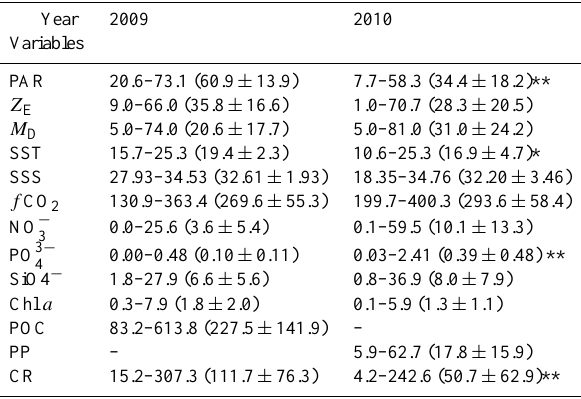
Table 1. Range of different variables with mean ± standard devi- ation (in parentheses) in surface water (2–3m) and averaged val- ues over euphotic depth ( Z E ; m) in the ECS in the spring of 2009 and 2010. Surface water variables include water tempera- ture (SST; ◦ C), salinity (SSS), and fugacity of CO 2 ( f CO 2 ; µatm). Variables of averaged value include nitrate (NO − ; µM), phos- 3 phate (PO 3 − ; µM), silicate (SiO − ;µM), chlorophyll a (Chl a ;mg 4 4 Chlm − 3 ) , particulate organic carbon (POC;mg Cm − 3 ) , primary production (PP;mg Cm − 3 d − 1 ) , and plankton community respi- ration (CR;mg Cm − 3 d − 1 ) . Values of Z E and mixed layer depth ( M D ;m) are also shown. In addition, photosynthetically active ra- diation (PAR; Em − 2 d − 1 ) is provided for reference. The Mann– Whitney Rank Sum test was applied for variable comparison be- tween 2009 and 2010, and the results are indicated